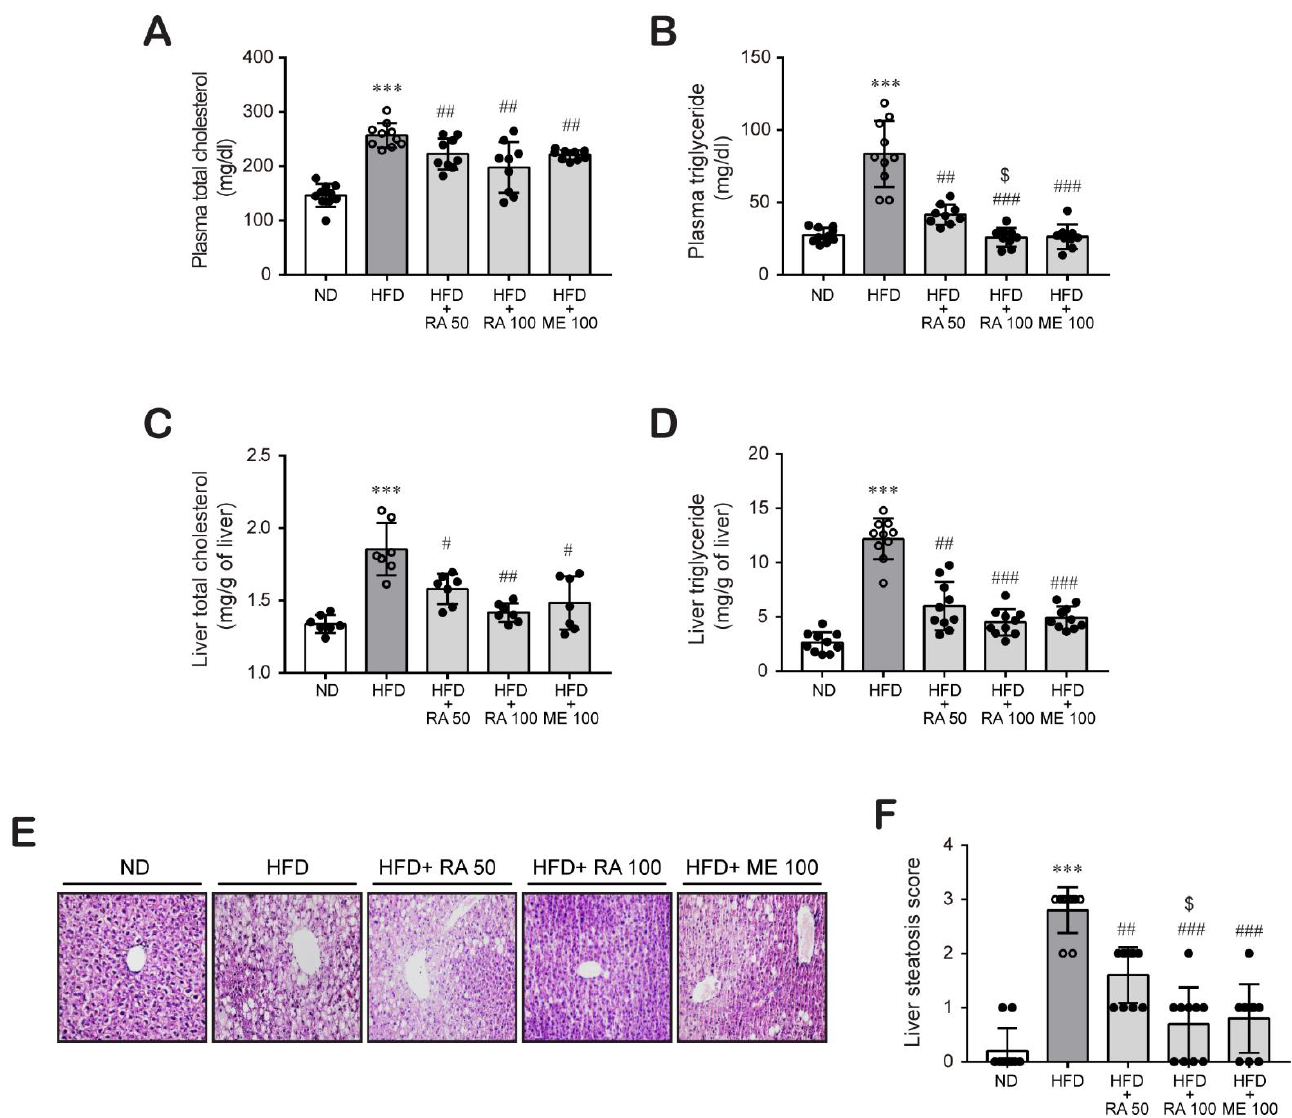
Figure 2. RA reduces plasma lipid and hepatic lipid accumulation and cellular injury in HFD-fed mice. Plasma total cholesterol ( A ) and triglyceride ( B ) levels were quantified in blood samples collected by heart puncture at sacrifice ( n = 9–10). ( C ) Hepatic total cholesterol ( n = 7) and ( D ) triglyceride levels were determined in liver tissue ( n = 9–10) as described in the Methods section. Data are presented as the mean ± SD. *** p < 0.001 vs. ND control mice; # p < 0.05, ## p < 0.01, ### p < 0.001 vs. HFD mice; $ p < 0.05 vs. RA 50. ( E , F ) H&E staining was performed to assess lipid accumulation in liver tissues (n = 10) ( E ), and histological scores for steatosis ranged from 0 to 3 in whole-value increments, where 0 = 0 – 5%, 1 = 6 – 33%, 2 = 34 – 66%, and 3 = 67 – 100% of hepatocytes positive for steatosis ( F ). Data are presented as the mean ± SEM. *** p < 0.001 vs. ND control mice; ## p < 0.01, ### p < 0.001 vs. HFD mice; $ p < 0.05 vs. RA 50. Scale bar, 100 µm.